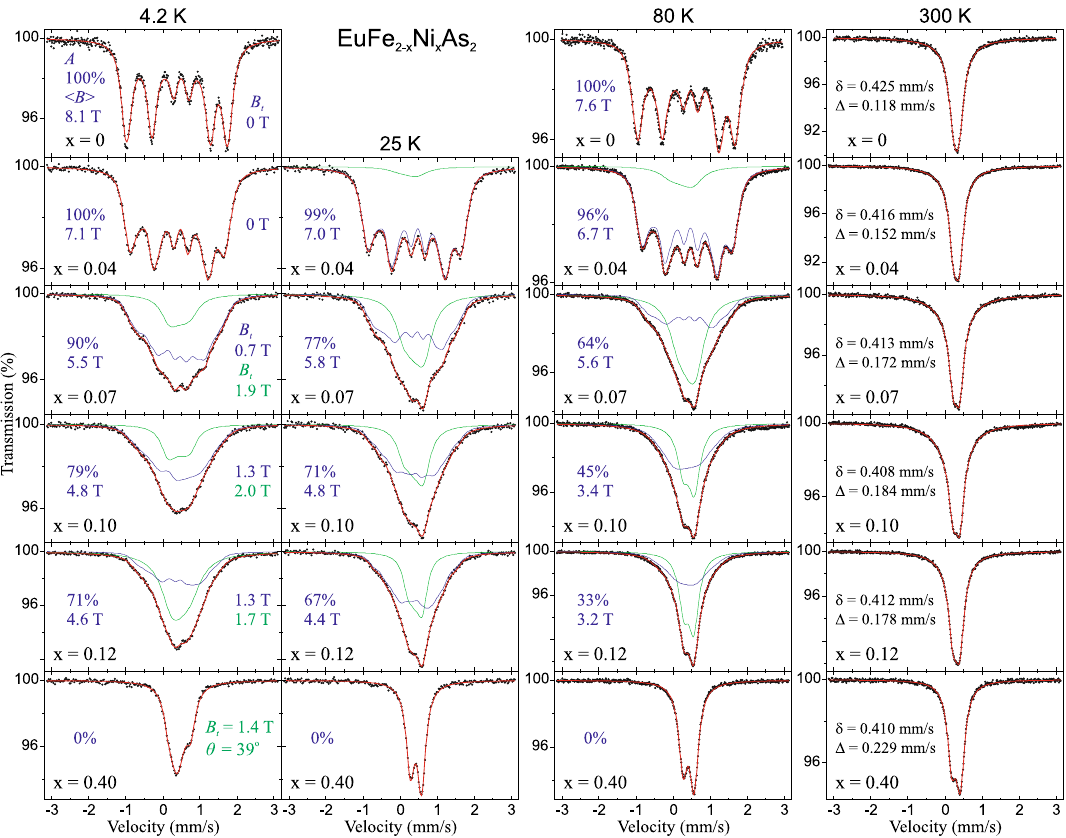
Figure 3. The 57 Fe Mössbauer spectra of EuFe 2−x Ni x As 2 measured at 4.2, 25, 80 and 300 K. (Inserted values in blue) The relative contribution of the SDW spectral component A , the average magnetic hyperfine field of SDW < B > , and the hyperfine transferred magnetic field due to the Eu 2+ ordering for iron in the SDW state. (Inserted values in green) The hyperfine transferred field due to the Eu 2+ ordering for iron in the “non- magnetic” state (the second spectral component), and the angle θ between the principal component of EFG at Fe nuclei (i.e. the crystallographic c -axis) and the Eu 2+ magnetic moment. The spectral center shift δ and the quadrupole splitting Δ at 300 K are shown. Errors for all values are of the order of unity for the last digit